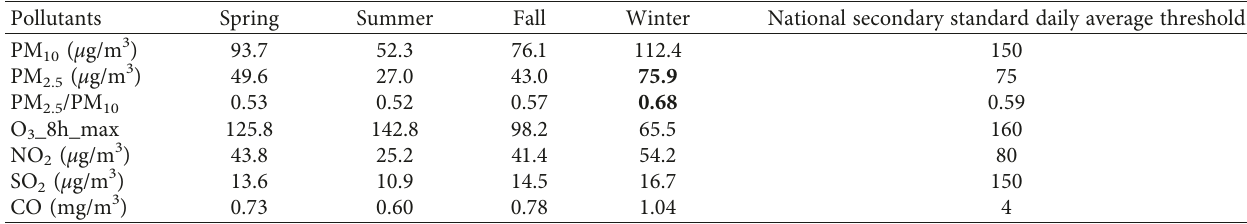
Table 4: Daily average value of the concentration of various pollutants in Jiangsu between September 2017 and August 2018.